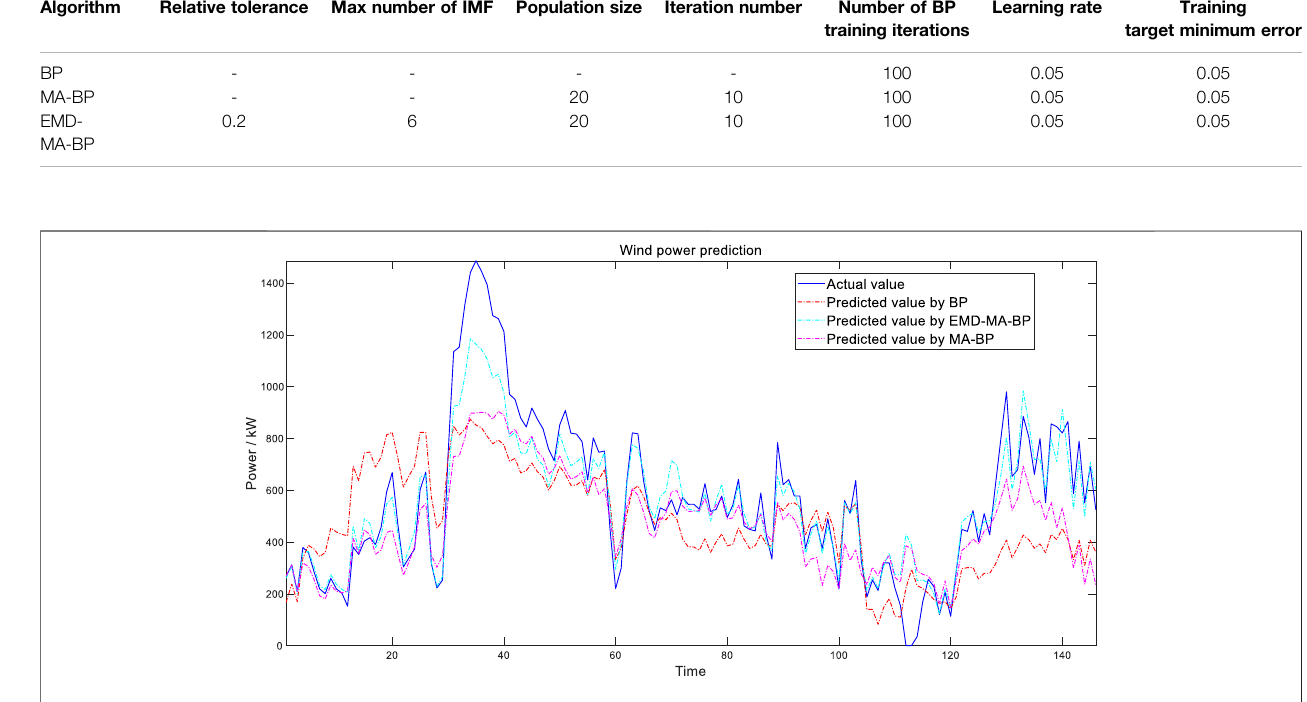
TABLE 1 | Parameter settings of each neural network algorithm. Algorithm